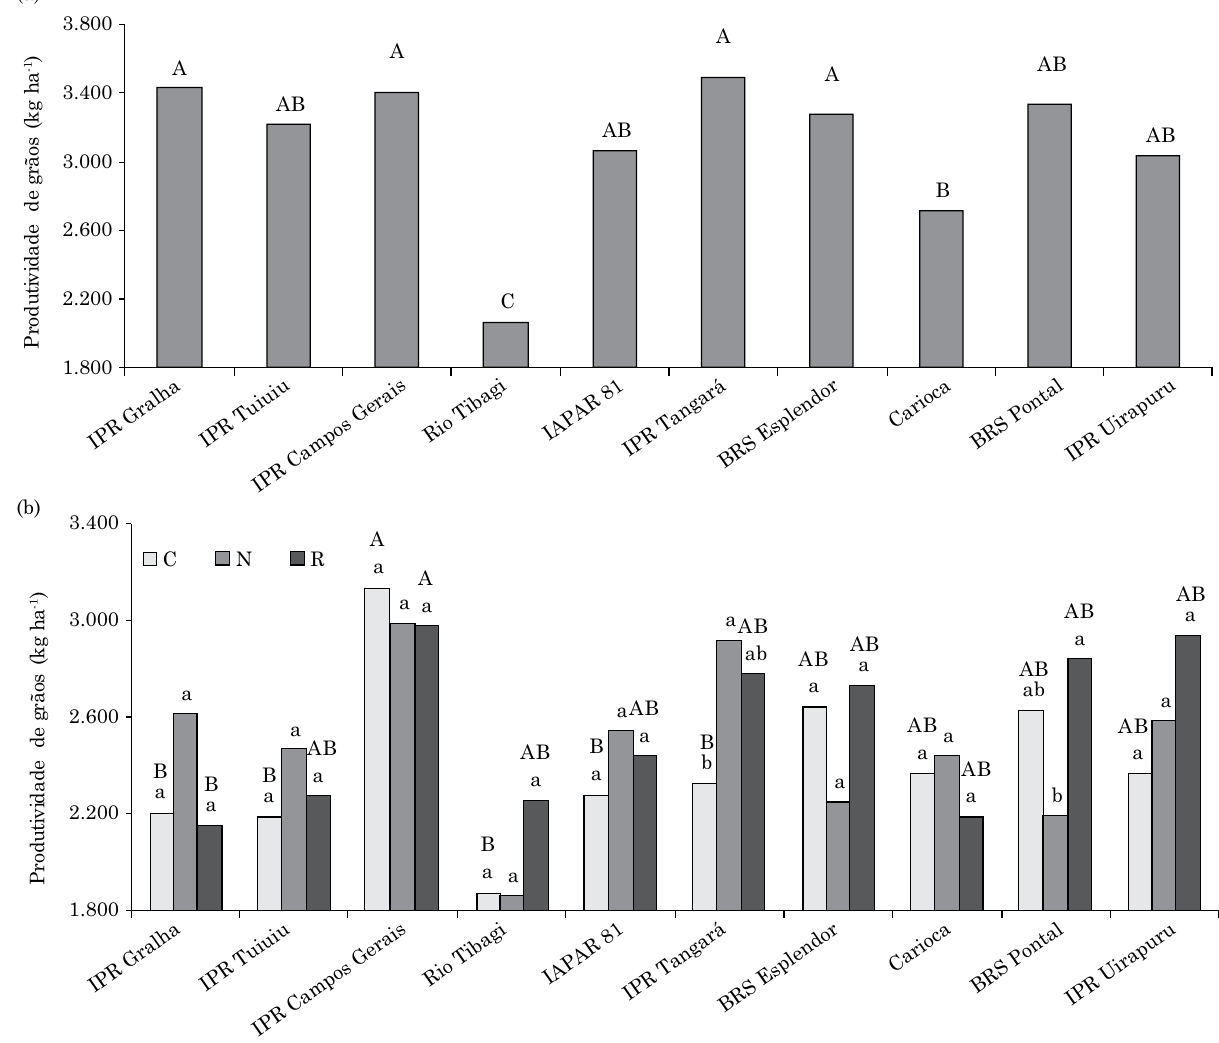
Figura 3. Produtividades de cultivares de feijoeiro comum na safra da seca-2012 (a) e das águas-2012/2013 (b) em Ponta Grossa, Pr, cultivados sem n e sem inoculação de sementes (C); com adubação nitrogenada (n) e com a inoculação das sementes com Rhizobium freirei (r). letras iguais, maiúsculas, entre cultivares no mesmo tratamento em nutrição nitrogenada, e minúsculas, entre tratamentos em nutrições nitrogenadas para a mesma cultivar, indicam ausência de diferença significativa pelo teste de Tukey a 5 %. Coeficientes de variação, safra da seca-2012: 12,2 % e safra das águas: 14,0